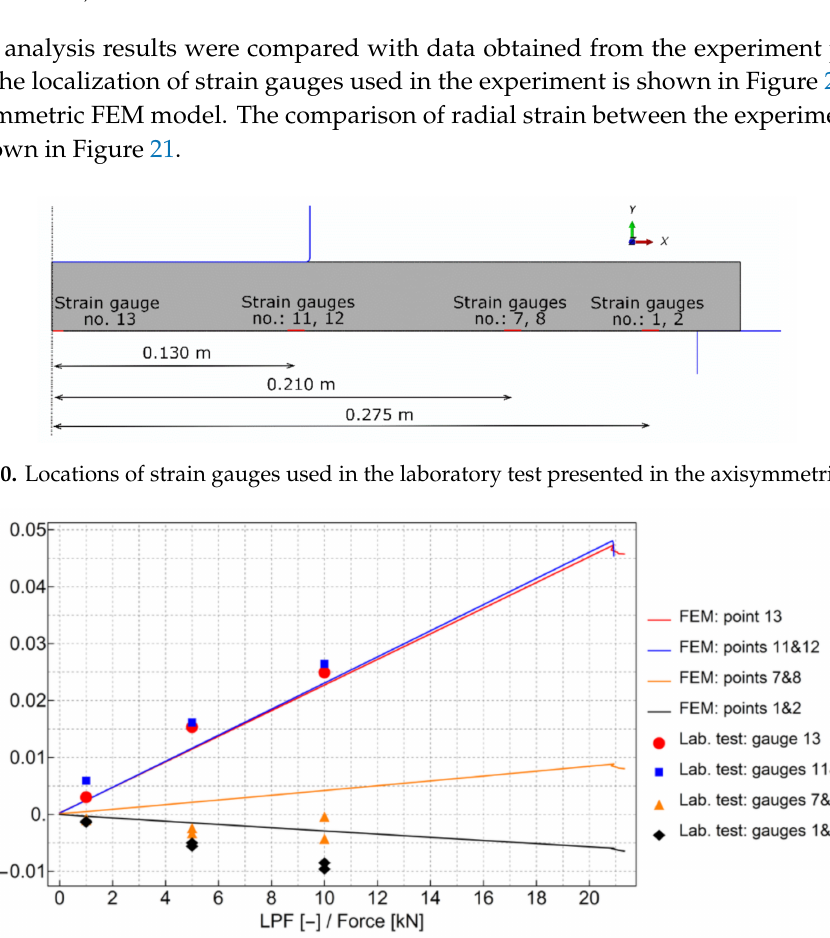
Figure 19. Contour plot of the maximum principal logarithmic measure of strain (3D model, global mesh size: 3 mm).